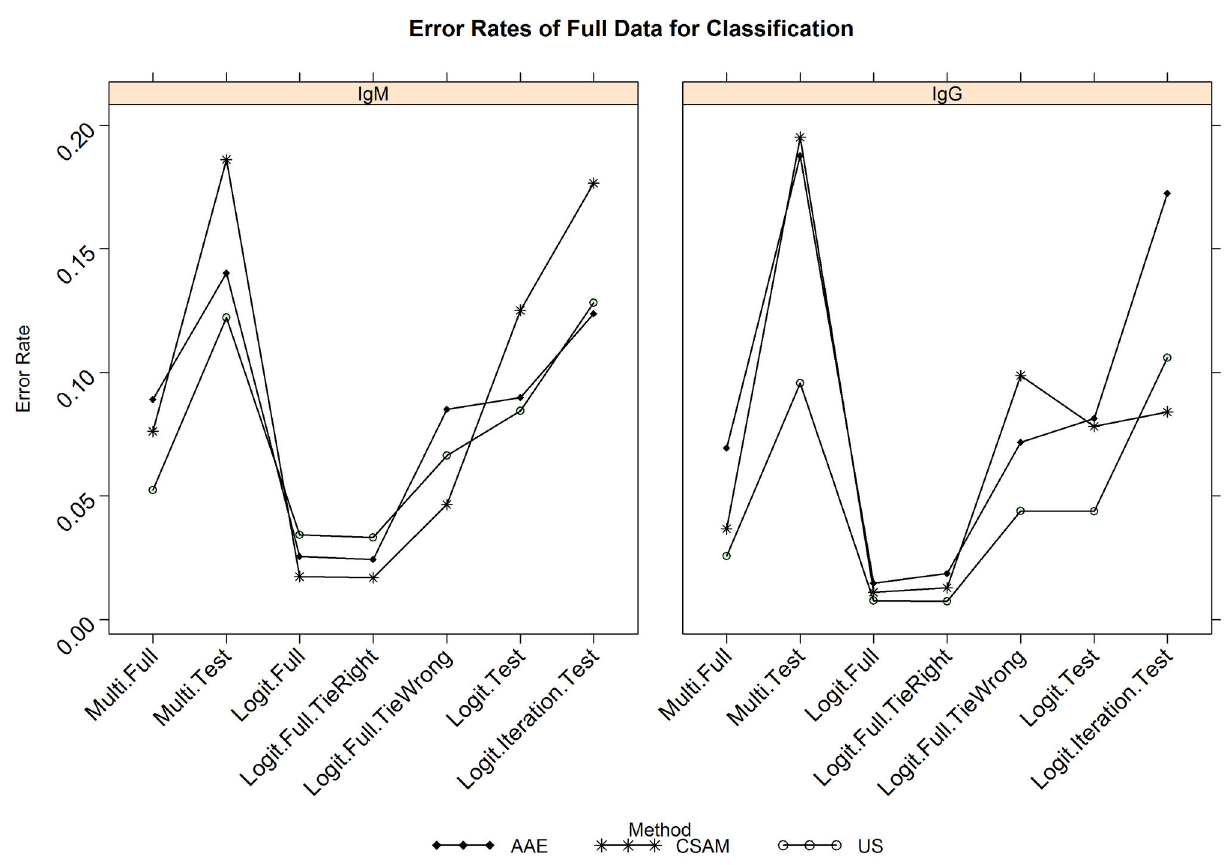
Figure 3. Error rates (%) for full data classification. Error rates (y-axes) where 1.0 is 100% incorrect classification (i.e. includes false positives and false negatives) are shown for the combined data set comprising the initial, geographic and summer 2011 sample sets. Error rates are shown for the 2 best classification options, multinomial linear regression (Multi) and logitboost (logit) on the x-axes. Full and test error rates are described in the analysis section of Materials and Methods. Logit. tie right/tie wrong is where the results that are tied are included in the error rates as being right or wrong. Logit. iteration is where more iterations of the classification scheme are performed than normally would be (usually equal to the number of data points in the set). This results in increased error rates due to over-fitting of the data such that any sample variation outside of the limits of the sample set used for deriving the classification rules results in an